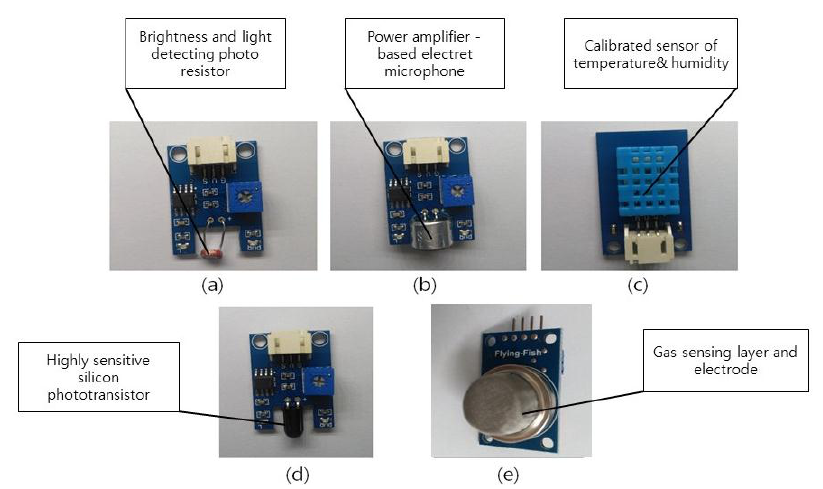
Figure 1. Environmental sensors and their parts: ( a ) light sensor; ( b ) sound sensor; ( c ) humidity sensor; ( d ) flame sensor; ( e ) fume sensor.